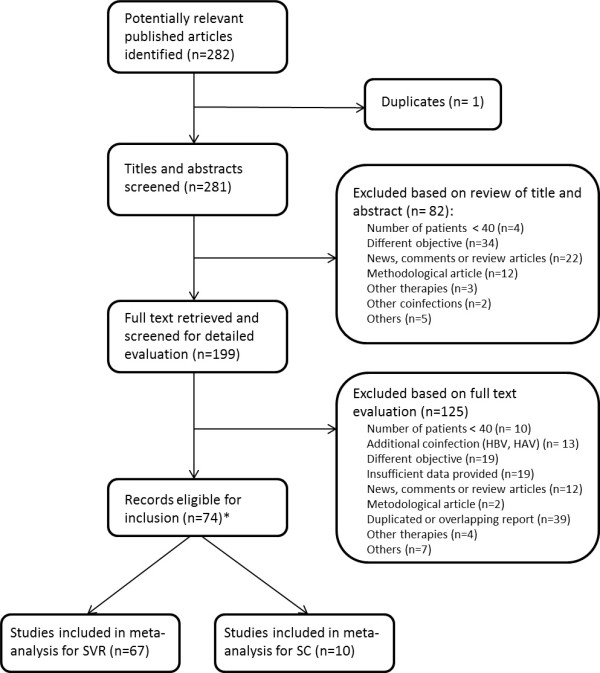
Flow diagram for the selection of articles for inclusion in the meta-analysis. *Two studies were potentially eligible for meta-analysis of both sustained virologic response (SVR) and spontaneous clearance (SC).